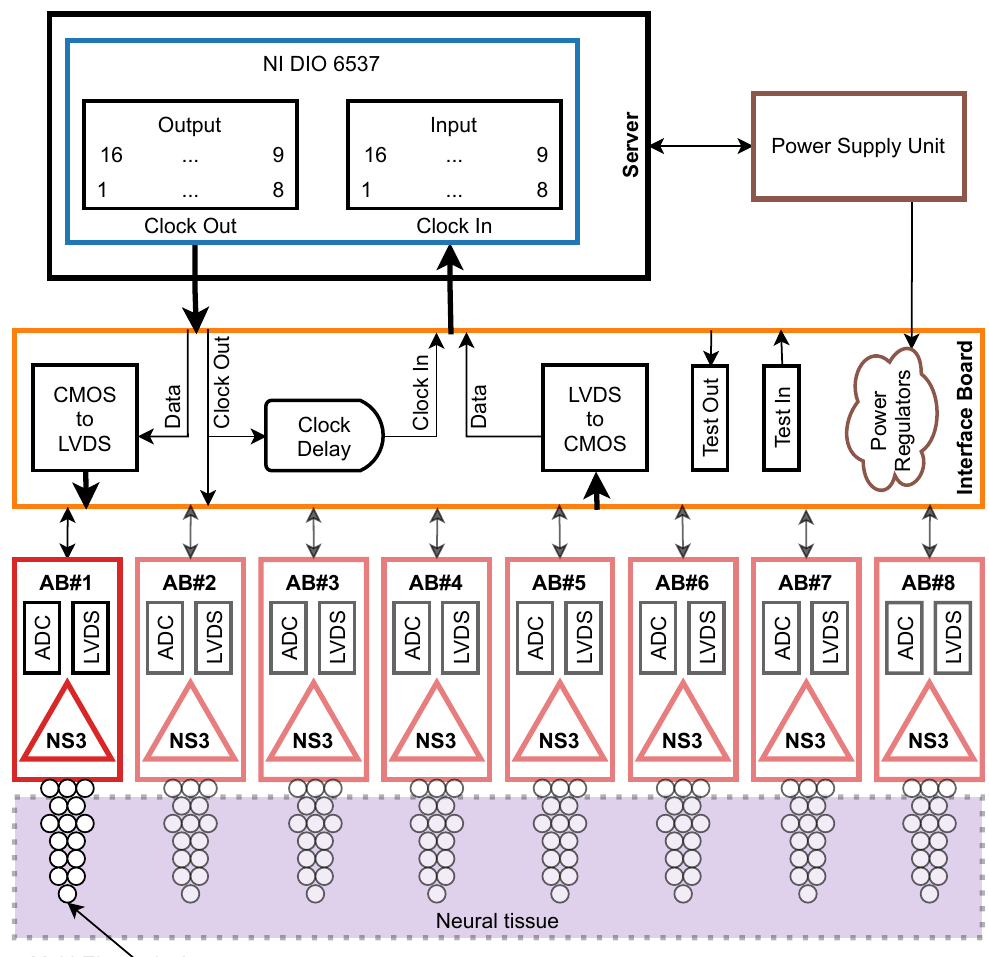
Figure 1. Hardware communication scheme of the presented system (object dimensions not to scale). NI DIO 6537 card (offering in total 16 output and 16 input digital data lines) resides in the Server and is connected with the Interface Board (IB) which manages signal and power distribution to/from up to eight ASIC Boards (ABs). Neurostim-3 (NS3) Application Specific Integrated Circuits (ASICs) are part of ABs and record electric potential changes on the Multi-Electrode Arrays (MEAs) dipped into neural